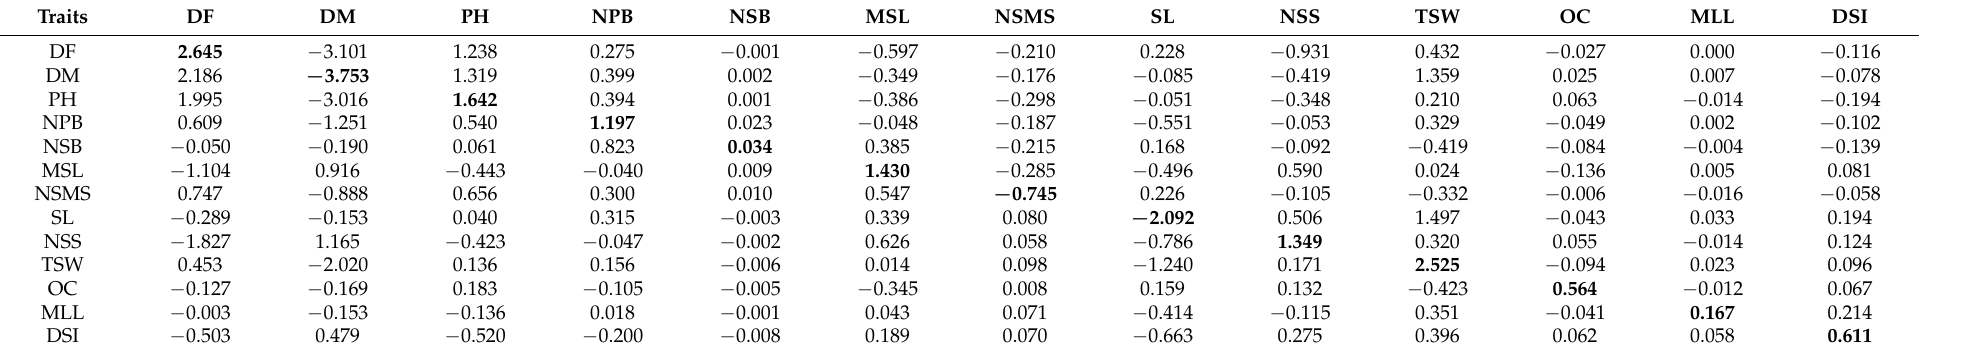
Table 8. Path coefficient based on genotypic correlation analysis for Sclerotinia stem rot resistance assessment parameters and yield component traits indicating direct effect (diagonal and bold) and indirect effect (above and below diagonal) on seed yield in Indian